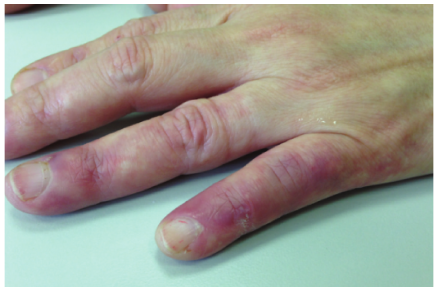
Figure 3: Recurrence of symptoms.